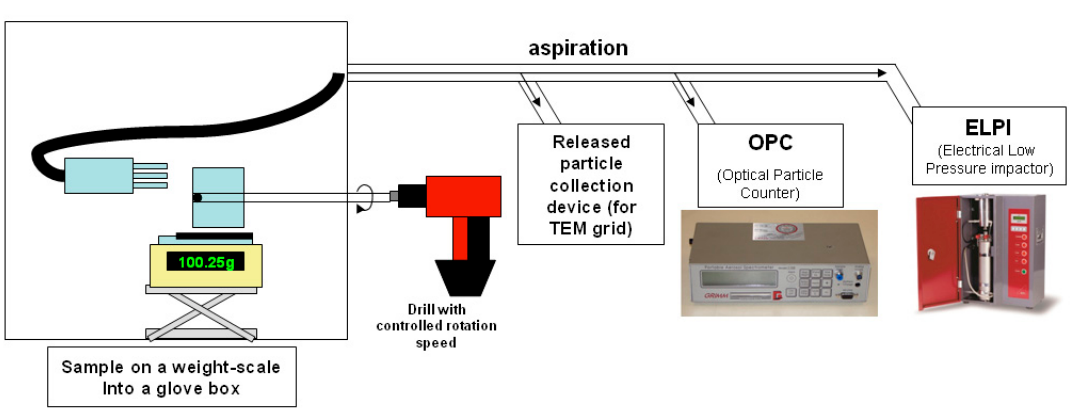
Figure 1. Representation of the wear simulation device in order to analyze airborne released particles.